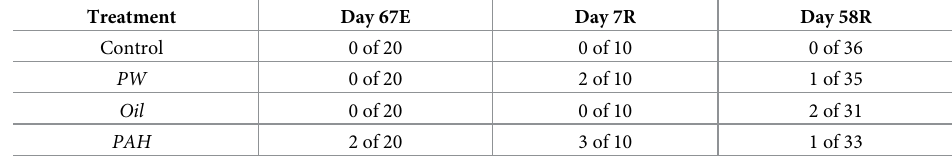
Table 5. Numbers of fish observed with macroscopically visible liver lesions after 67 days of exposure (67E), and after 7 (7R) and 58 days (58R) of recovery. Treatment PW Oil PAH 2 of 20 1 of 33 No statistical differences from control were observed (Fisher’s exact